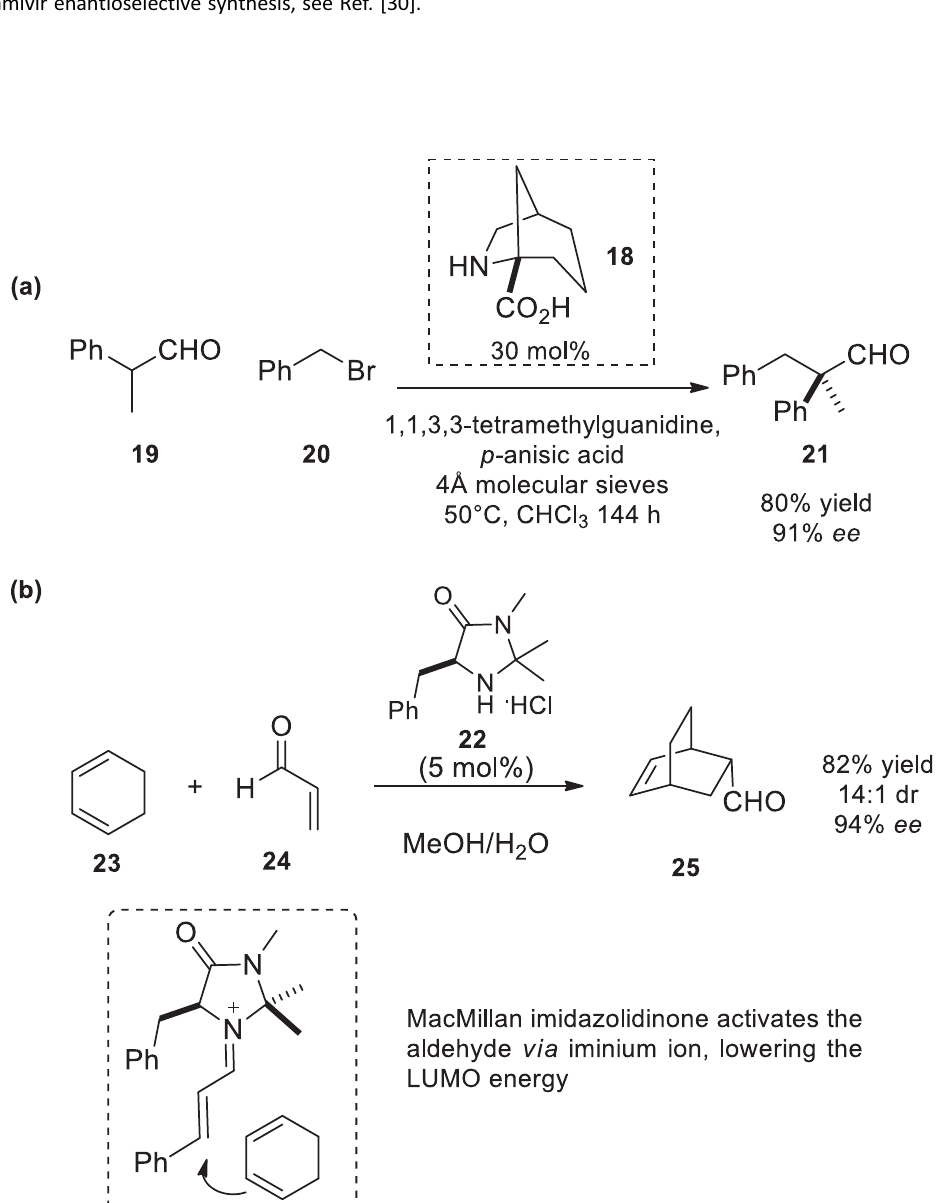
Figure 7 . (a) Asymmetric alkylation of α -branched aldehydes catalysed by secondary amine 18; (b) direct Diels – Alder reaction catalysed by MacMillan imidazolidinone